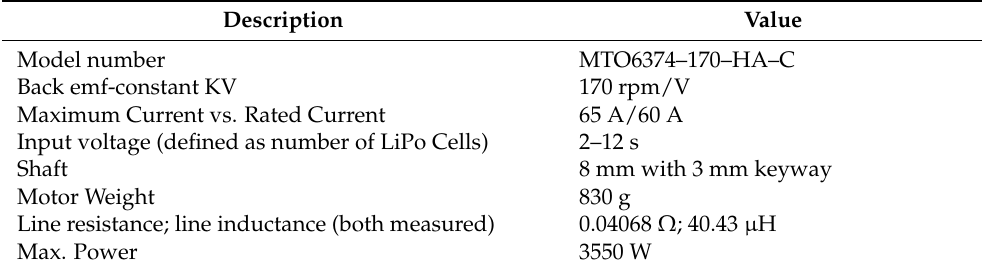
Figure 9. BMPS: ( a ) EG; ( b ) Back-emf measurements. Table 2. BPMS machine technical